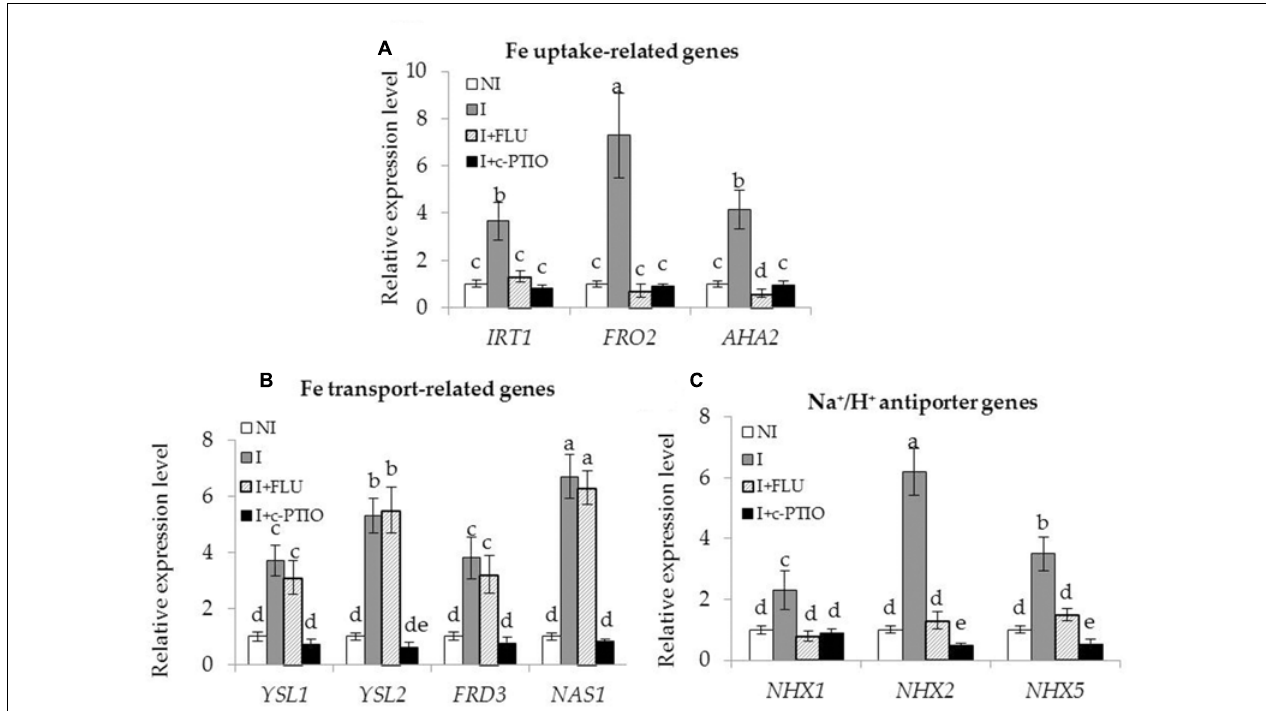
FIGURE 10 | Treatment with FLU or c-PTIO affected the expression of Fe acquisition and Na + /H + antiporter genes in SA03-inoculated Chrysanthemum plants. After 10 days of SA03-inoculation, plants were subjected to saline–alkaline stress for 4 weeks with FLU or c-PTIO treatment. These plants were used to examine the transcription of (A) Fe uptake-related ( IRT1 , FRO2 , and AHA2 ), (B) Fe transport-related ( YSL1 , YSL2 , FRD3, and NAS1 ), and (C) Na + /H + antiporter ( NHX1 , NHX2, and NHX5 ) genes by qRT-PCR. Data are expressed as the mean values of three replicates ( ± SE). Different letters indicate significant differences using two-way ANOVA followed by the Duncan’s multiple range test at P <